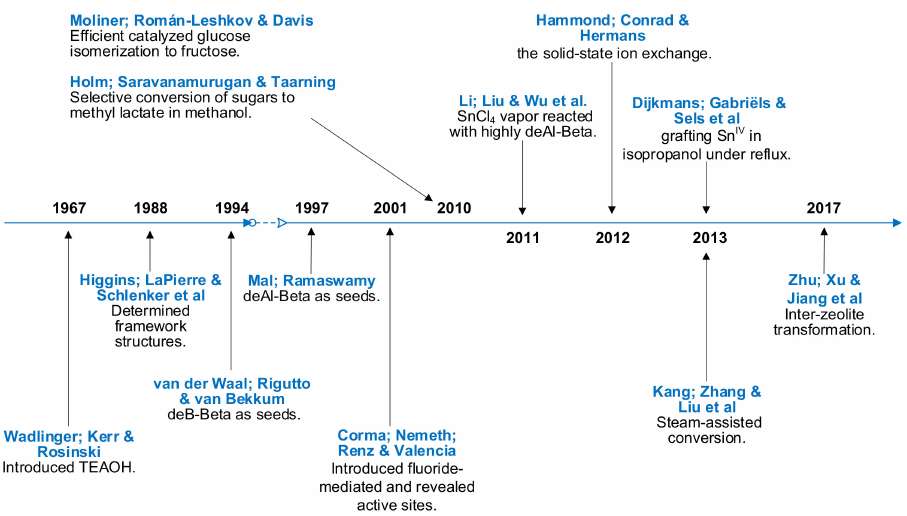
Figure 1. Developments in the synthesis strategies of Sn-Beta zeolite. Left to right: 1967 Ref. [22]; 1988 Ref. [23]; 1994 Ref. [24]; 1997 Ref. [25]; 2001 Ref. [26]; 2010 Refs. [11,12]; 2011 Ref. [27]; 2012 Ref. [28]; 2013 Ref. [29] (bottom); 2013 Ref. [30] (top); 2017 Ref.